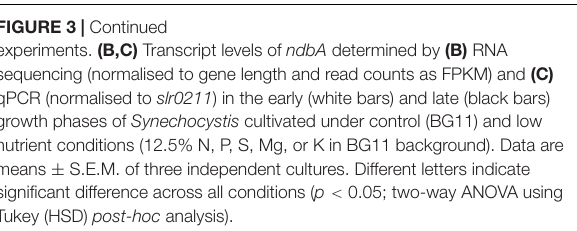
FIGURE 3 | Continued experiments. (B,C) Transcript levels of ndbA determined by (B) RNA sequencing (normalised to gene length and read counts as FPKM) and (C) qPCR (normalised to slr0211 ) in the early (white bars) and late (black